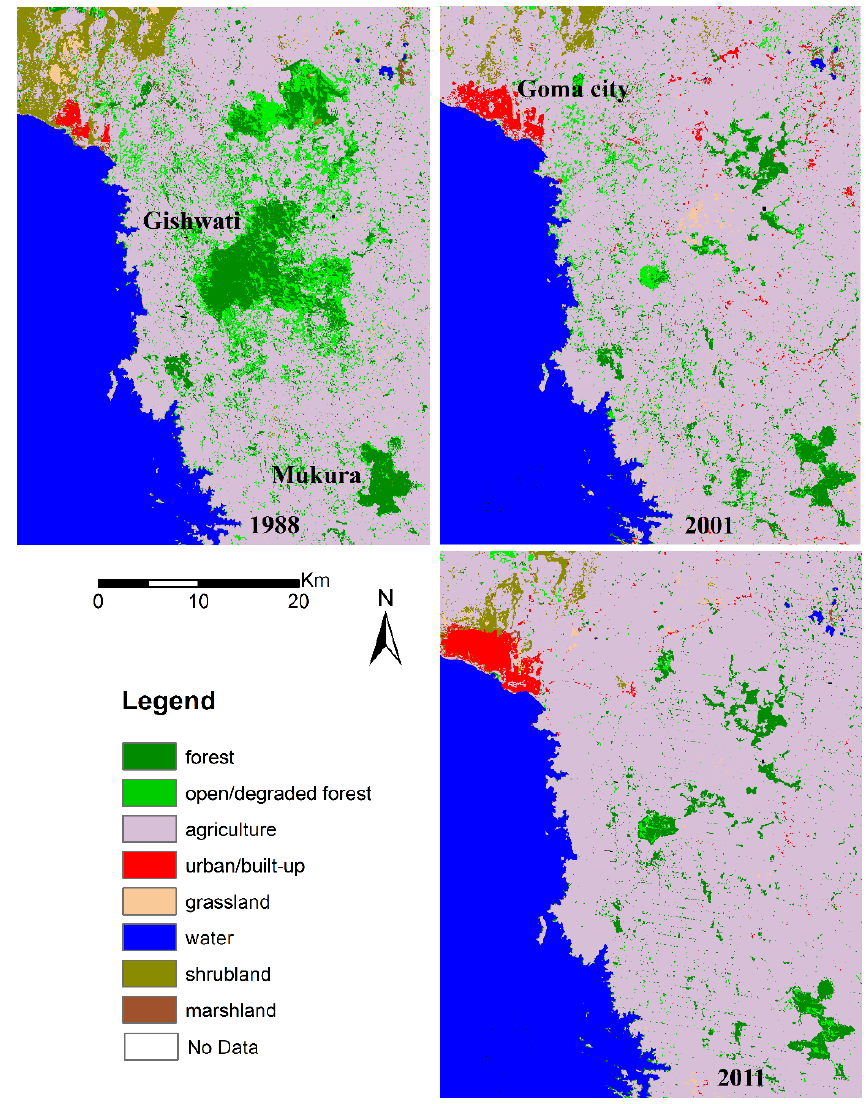
Figure 9. Time series of detailed land-cover maps in the study area near Goma city in Rwanda for 1988, 2001 and 2011, respectively. This mapped region is outlined in blue in Figure